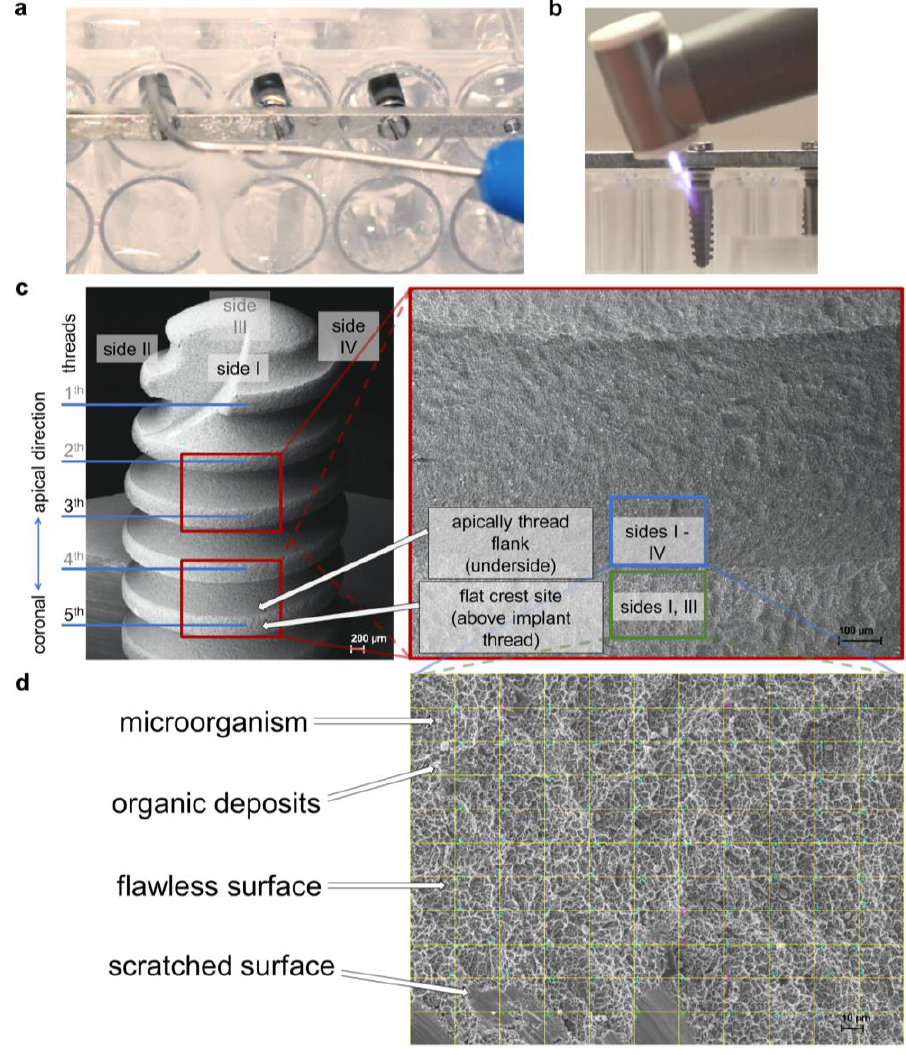
Figure 5. Study setup. ( a ) WaterJet treatment of implant sample in the microtiter plate; ( b ) cold atmospheric pressure plasma treatment of implant sample in the microtiter plate; ( c ) lower magnification scanning electron micrographs showing the implant (scale bar = 200 µm) and the location of threads 3 and 5 (scale bar = 100 µm), where images were taken for later analysis; ( d ) micrograph at 500× magnification with digital grid for quantitative analysis of microbes, organic deposits, flawless implant surface, scratched implant surface, and unknown objects, scale bar = 10 µm.